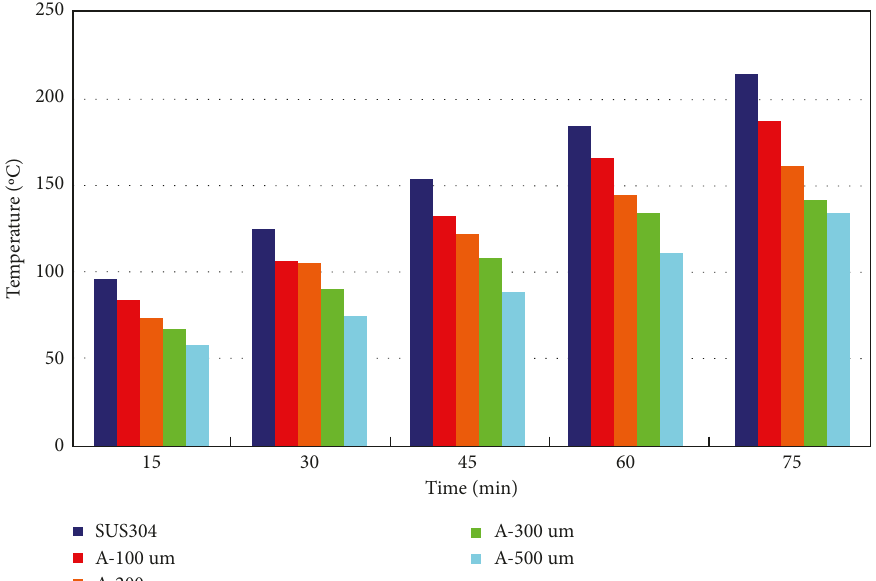
Figure 5: The temperature change analysis of A.